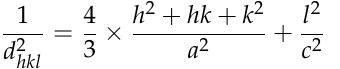
Figure 1. The XRD patterns of the W-type SrYb hexaferrite Sr 0.85 Yb 0.15 Zn 1.5 Co 0.5 Al x Fe 16 − x O 27 (0.00 ≤ x ≤ 1.25).